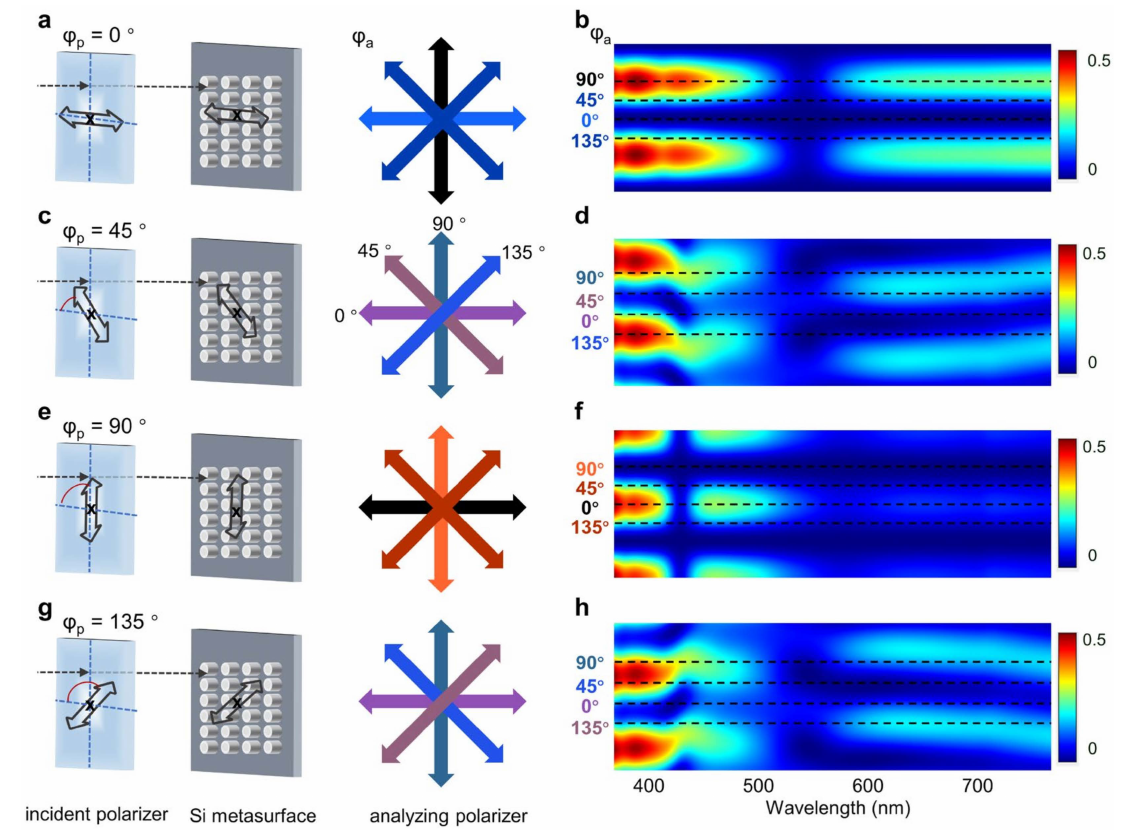
Figure 5. Reflection spectra as a function of polarization angles. ( a , c , e , g ) Measurement schemes for different angles of the incident polarizer ( ϕ p ) and the analyzing polarizer ( ϕ a ); each output arrow is colored in the observed color. ( b , d , f , h ) Corresponding calculated reflection plots for rotation of the analyzing polarizer (0 ◦ < θ < 360 ◦ , 1 ◦ steps).